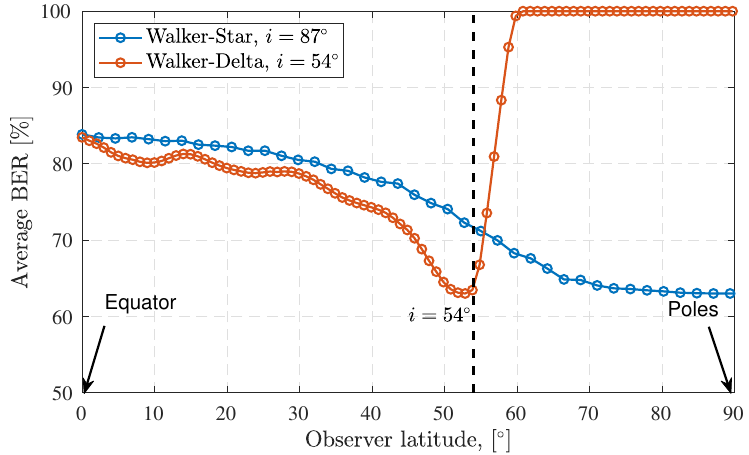
Figure 10. The average BER for case I while varying the target IoT device latitude, showing the Walker-Star for i = 87 ◦ and Walker-Delta for i = 54 ◦ , the rest of the simulation parameters are listed in Table 1.